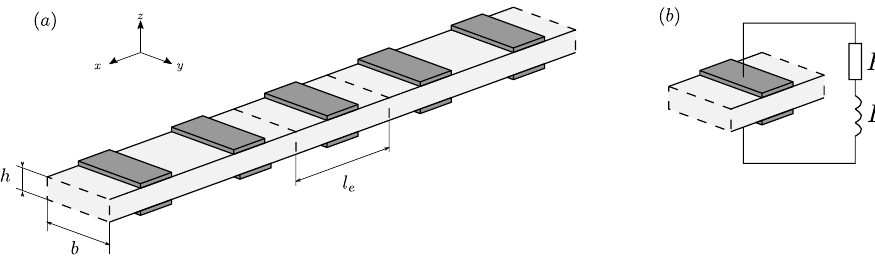
Figure 1. A concept of an electromechanical periodic structure ( a ), unit cell ( b